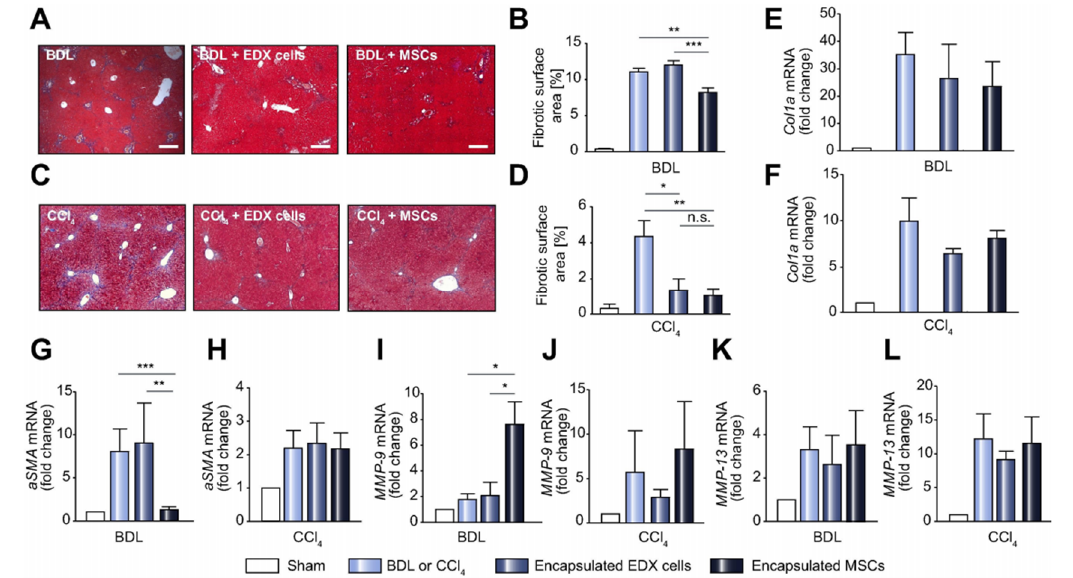
Figure 3. Transplanted microencapsulated mesenchymal stem cells can be used to aid liver fibrosis. ( A – D ) MSCs were encapsulated in novel alginate-polyethylene glycol microspheres and transplanted into BDL or CCl4-induced mice, then livers were harvested after 15 days or 4 weeks, respectively. ( A , C ) Morphometric quantification of Masson’s trichrome stained sections was calculated, showing a decrease in fibrotic surface area with encapsulated MSC treatment. Scale bars are 400 μm. ( E – L ) Real time-PCR analysis was conducted for Col1a , α-SMa , MMP-9 , and MMP-13 gene markers. The results reveal reduced expression of collagen type 1 in with encapsulated MSC treatment compared to untreated. Increase in α -SMa , MMP-9 , and MMP-13 gene expression was observed in both BDL and CCl4-induced models when treated with encapsulated MSCs compared to encapsulated foreskin fibroblasts. MMP-9 is known to be overexpressed in cell population such as neutrophils and lymphocytes, which can curb accumulation of extracellular matrix and thus reduce liver fibrosis pathology. Data presented as fold change with respect to housekeeping genes and expressed as mean value ± SEM. * p < 0.05, ** p < 0.01, *** p < 0.001. Reprinted with permissions from Meier et al. [78].